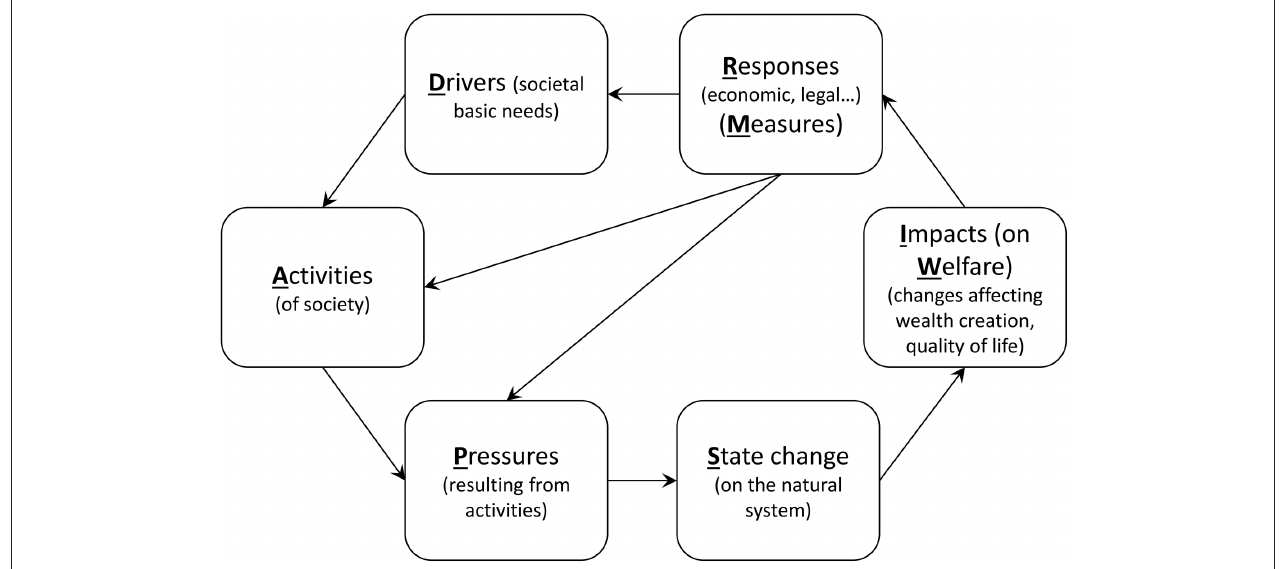
FIGURE 1 | Drivers, Activities, Pressures, State changes, Impacts on human Welfare, and management Responses as Measures [DAPSI(W)R(M)] scoping framework (Wolanski and Elliott, 2015). This management framework quantifies and assesses the Pressures, State changes, and Impacts on human Welfare but manages (using Responses as Measures) the Drivers and